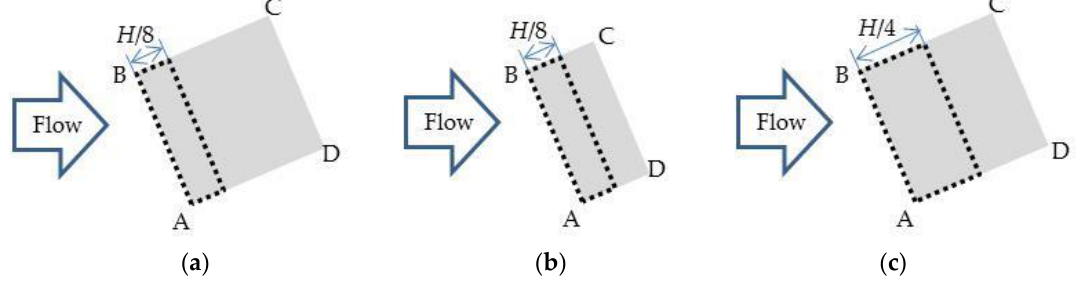
Figure 7. Top view of the windward quarter and windward half of the roof. ( a ) Windward quarter, HAR = 1.00; ( b ) Windward half, HAR = 0.50; ( c ) Windward half, HAR = 1.00.